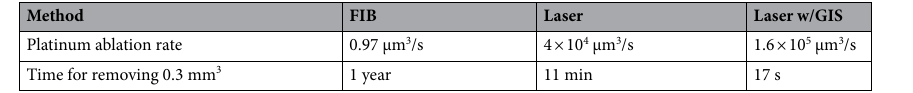
Table 1. Comparison of the removal rates of the FIB and the femtosecond pulsed laser used in this work. The same material (here, Platinum) has undergone both the FIB and the laser processes.